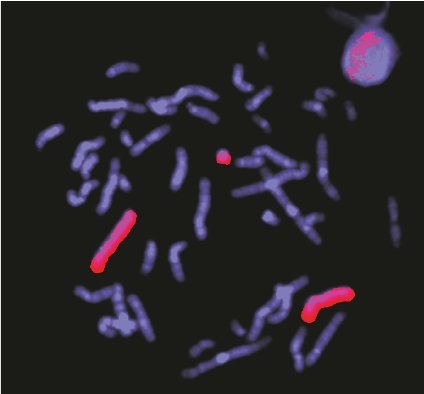
Figure 3: WCP probe for chromosome 4.